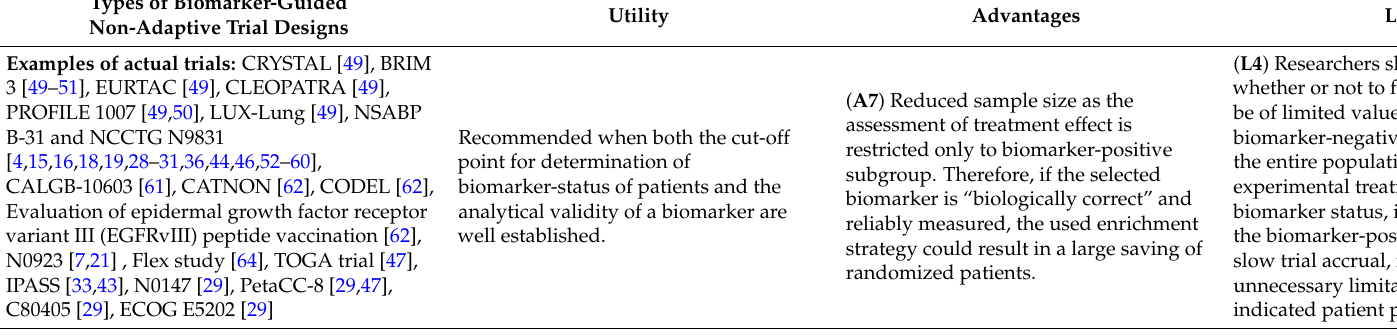
Types of Biomarker-Guided Non-Adaptive Trial Designs